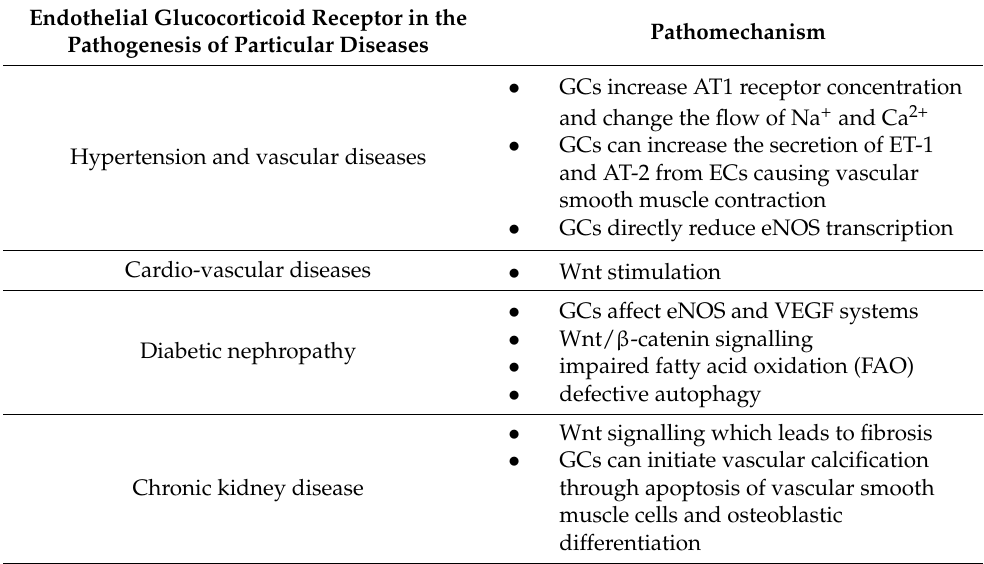
Table 1. Patomechanism and potential role of endothelial glucocorticoid receptor in the pathogenesis of particular